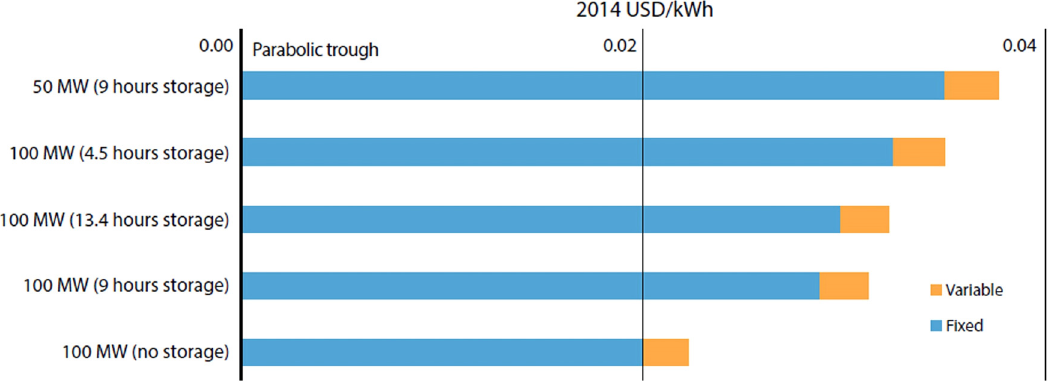
Table 15: Cost of PTCs used in SHIPs [ 152